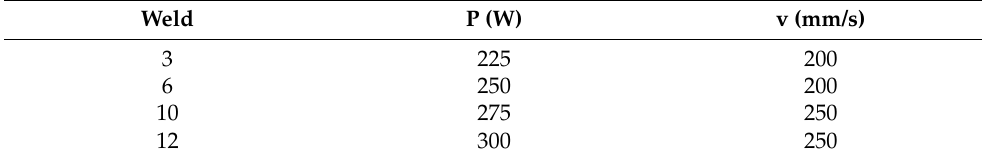
Table 10. The best-evaluated welds.